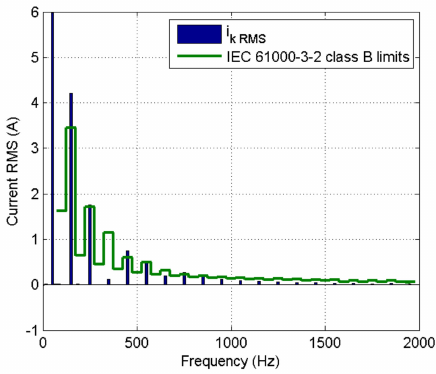
Figure 11. Testing for harmonic current emissions. RMS values of the harmonic components of the current drawn by the tested drive for the motor loaded with the full rated torque at n = 10,000 rpm and for the PWM duty cycle of 81%. In full-rated operations, the harmonics exceed the limits.